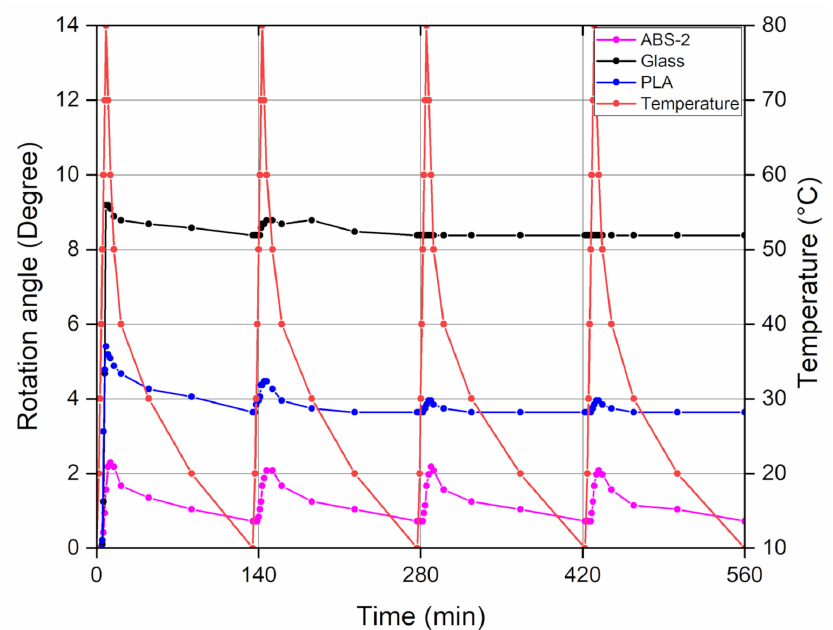
Figure 8. The rotation angle variations of all bolted joints under cyclical temperature changes from 10 ◦ C to 80 ◦